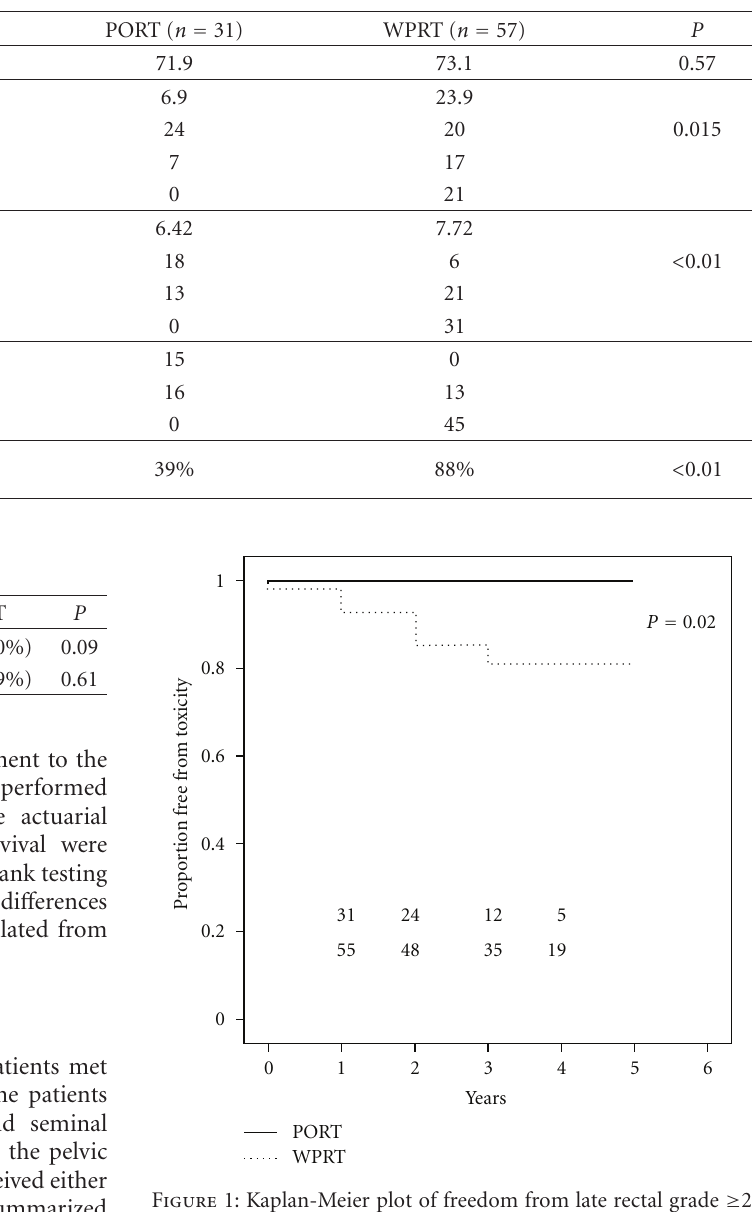
Table 1: Pretreatment characteristics.